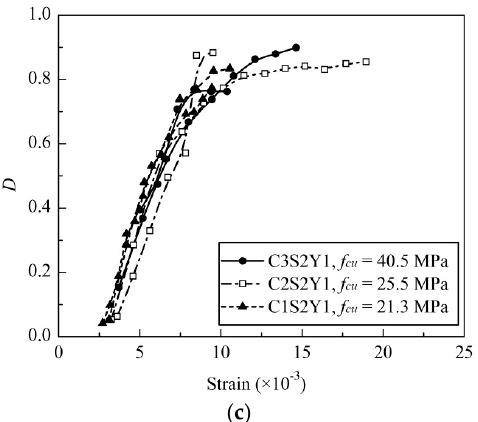
Figure 7. ( a ) Effect of stirrup volume ratio on damage evolution; ( b ) effect of stirrup yield strength on damage evolution; and ( c ) effect of concrete strength on damage evolution.